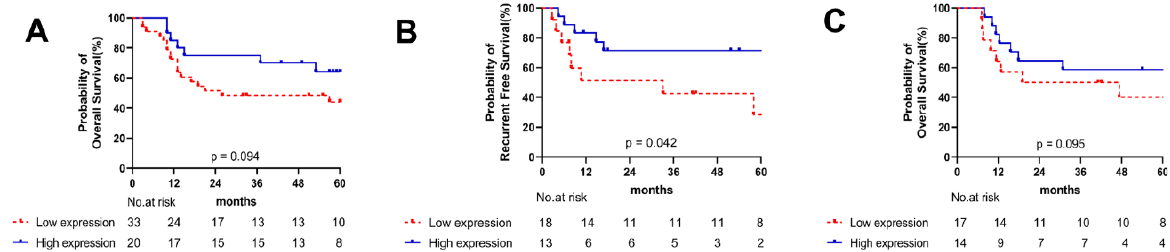
Figure 5. Kaplan – Meier survival curves for relapse-free survival (RFS) and overall survival (OS) based on miR-769-3p expression. High miR-769-3p expression is associated with longer OS ( A ) in HNSCC data set (GSE144711, n = 53). Patients with a high miR-769-3p expression in tumor cells demonstrated a longer RFS ( B ) and OS ( C ) than patients with a low miR-769-3p ( p = 0.042 and p = 0.095, respectively) using ISH in the OSCC FFPE samples (n = 31). Patients were divided into two groups (miR-769- 3p_high and miR-769-3p_low) based on their miR-769-3p expression levels. p values were determined using the log-rank